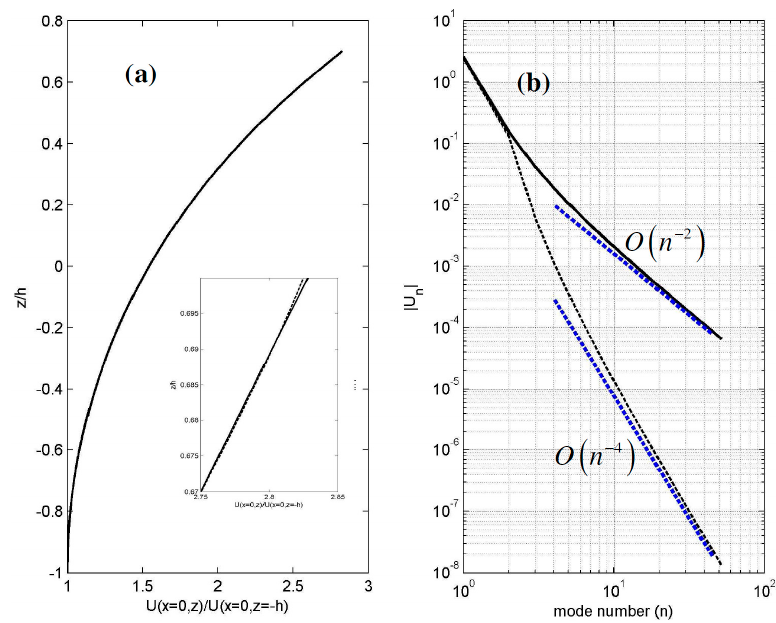
Figure A1. Modal representation of potential flow U ( x , z ) = κ cosh [ κ ( z + h )] sin ( κ x ) at x = 0 between horizontal bottom z / h = − 1 and an upper surface η ( x ) = ε h sin ( κ x ) with ε = 0.7 and κ h = 1. ( a ) Comparison of the present modal series defined by Equation (1) shown by using dashed lines against the potential velocity field U ( x = 0, z ) , shown by using solid lines. ( b ) The calculated rate of decay of the mode amplitudes | U n | is shown by using solid lines and the improvement obtained by including additional free-surface mode by using dashed lines. The asymptotic trends are indicated in the figure by using blue dotted lines.